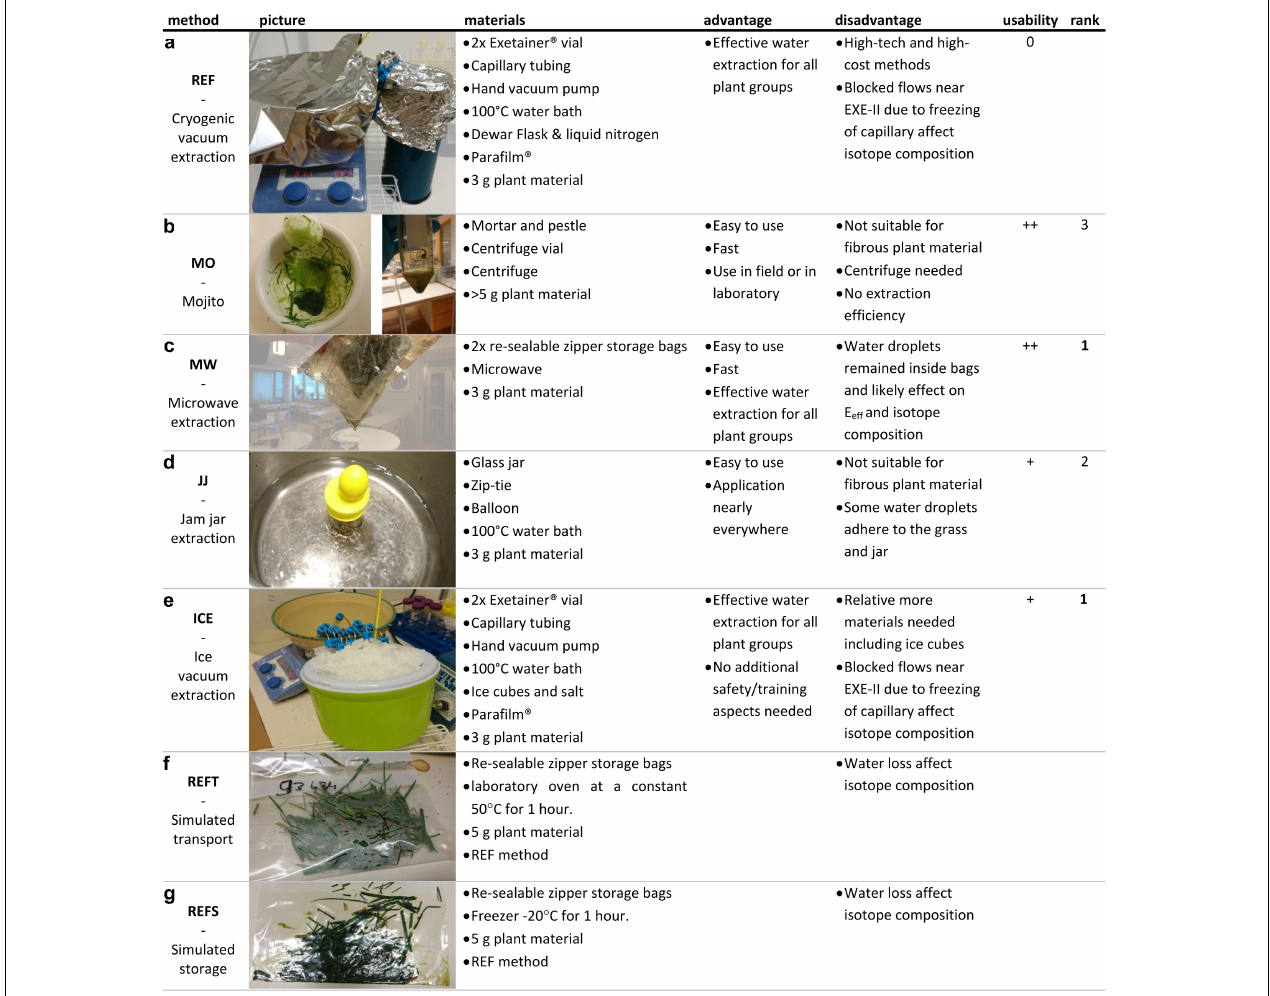
FIGURE 1 | The different plant water extraction techniques used: (a) REF (cryogenic vacuum), (b) MO (mojito, left) and mojito after centrifuge (right), (c) MW (microwave), (d) JJ (jam jar), (e) ICE (ice cube), (f) REFT (REF with simulated transport, grass samples after 1 h in the oven to simulate transport of the material) and (g) REFS (REF with simulated storage, the grass samples thawing after 1 h in the freezer with exfiltration, i.e., loss of plant water). For each method the different materials needed, advantages, disadvantages, usability (easy, neutral, challenging indicated as ++ , + , or 0) and overall rank (best to reasonable indicated as 1 – 3; based on Z -scores) are listed in the respective